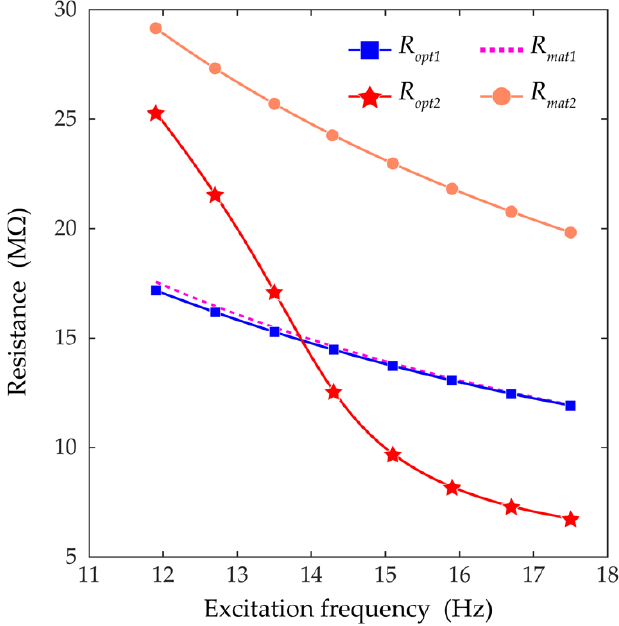
Figure 7. The optimal load resistances and the matched load resistances at each excitation frequency are plotted. R opt1 and R opt2 are the optimal resistances for beam 1 and beam 2, respectively. R mat1 and R mat2 are the matched resistances for beam 1 and beam 2, respectively. The resistances are calculated at the excitation frequencies from 11.9 to 17.5 Hz with increments of 0.1 Hz. The third-harmonic distortions for calculating the optimal resistances were obtained when the excitation amplitude was 6 m/s 2 .